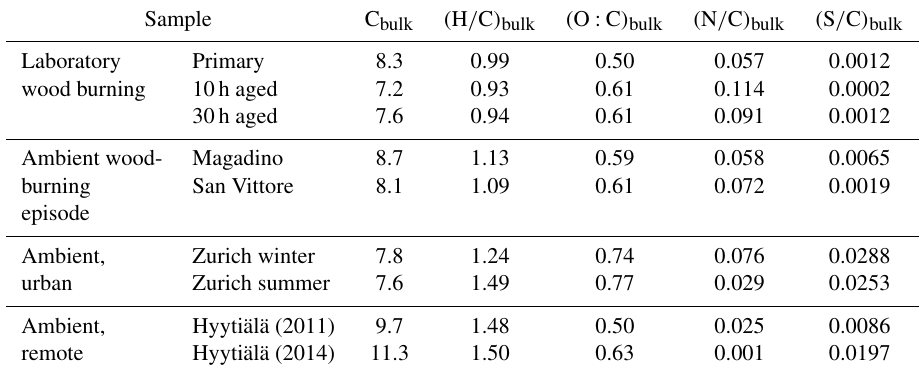
Table 2. Bulk properties of organic aerosol.